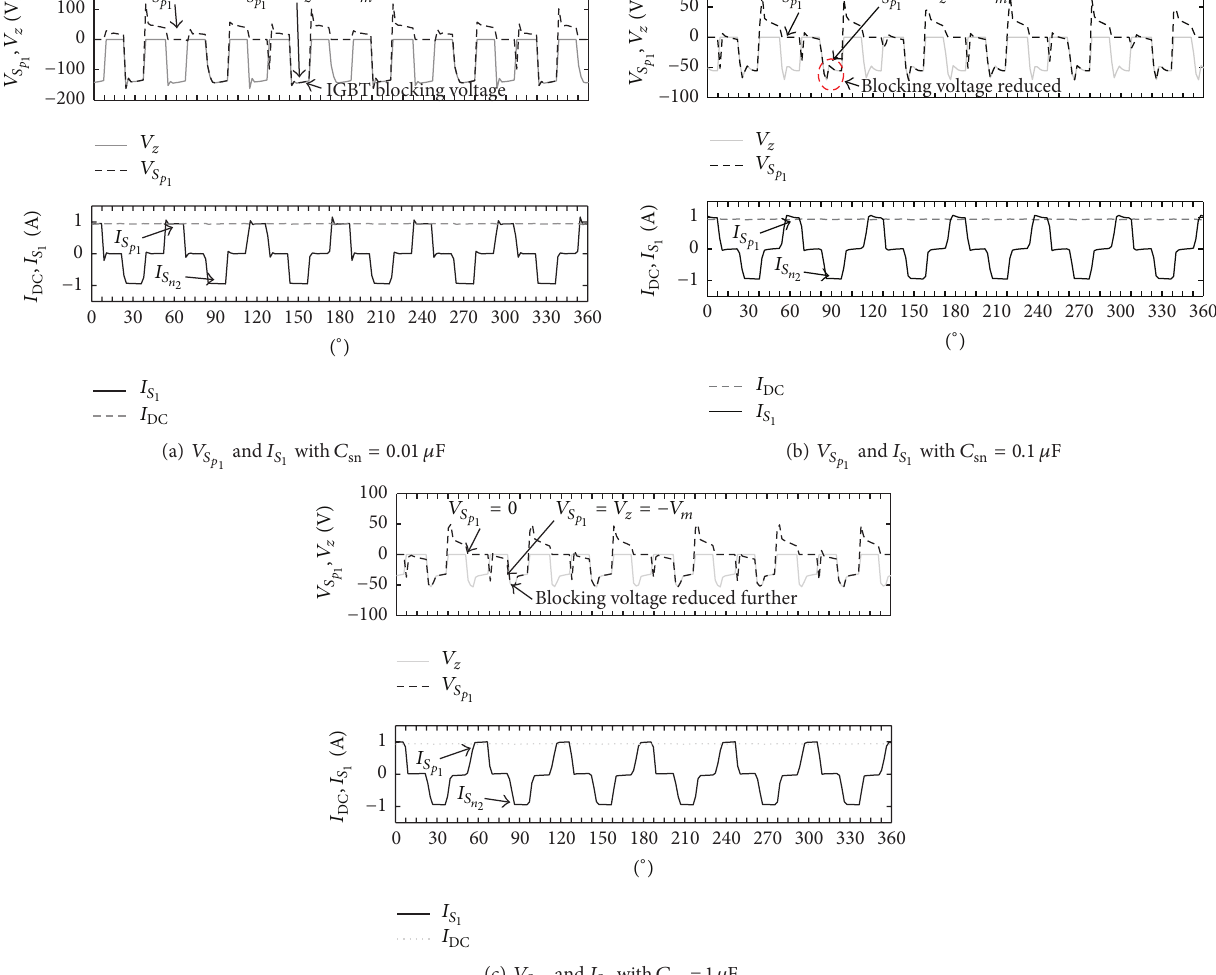
Figure 11: Voltage across reinjection IGBT 𝑆 𝑝